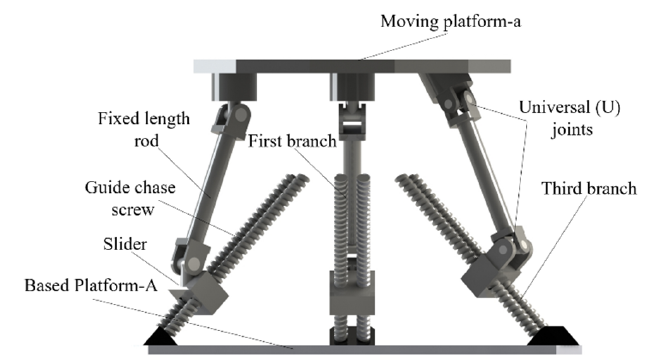
Figure 3. 3PUU moving part.